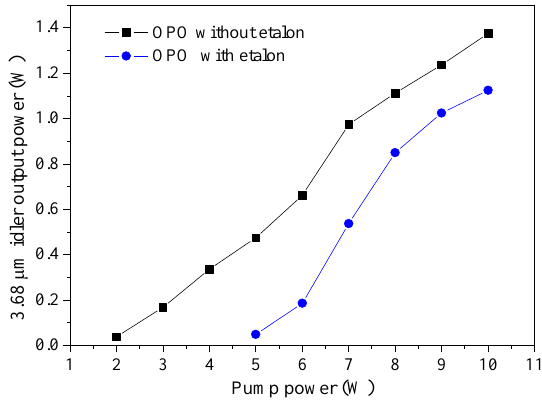
Figure 5. Output power of the 3.68 μm idler versus incident pump power .